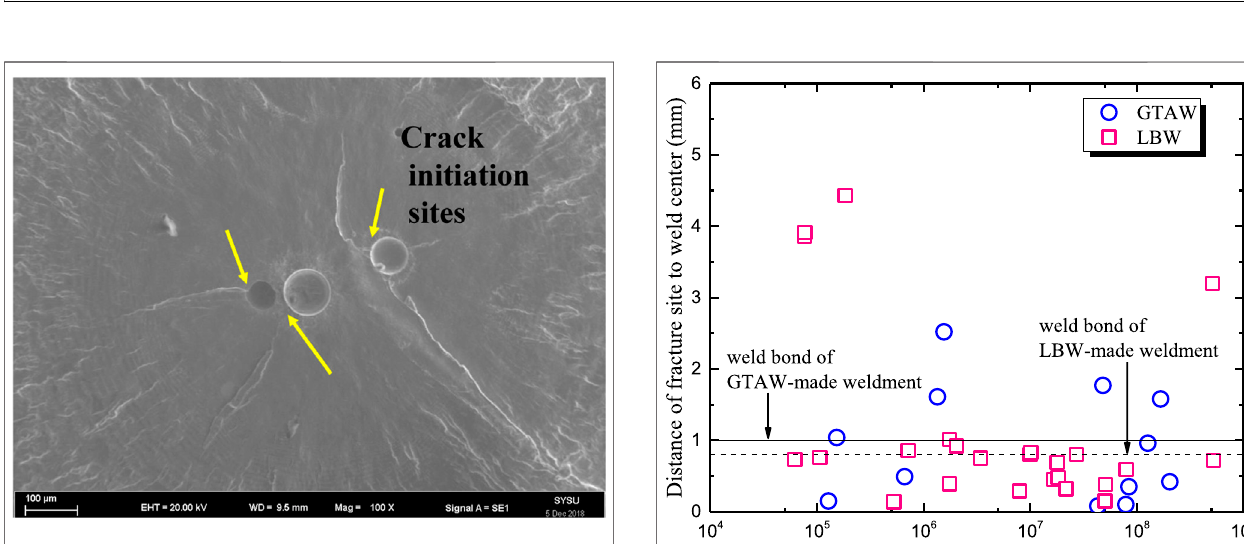
FIGURE 9 | The origins of a typical multiple cracks for the specimen (LBW) failed at 1.82 × 10 7 cycles.